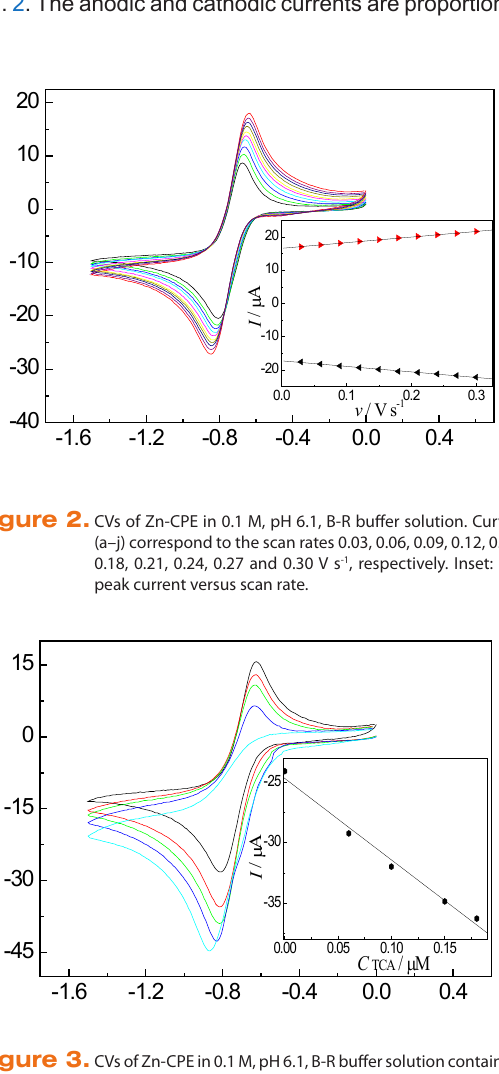
Figure 3. CVs of Zn-CPE in 0.1 M, pH 6.1, B-R buffer solution containing (a–e) 0, 0.06, 0.10, 0.15 and 0.18 μM TCA with the scan rate as 0.15 V s -1 . Inset: the cathodic peak current versus TCA